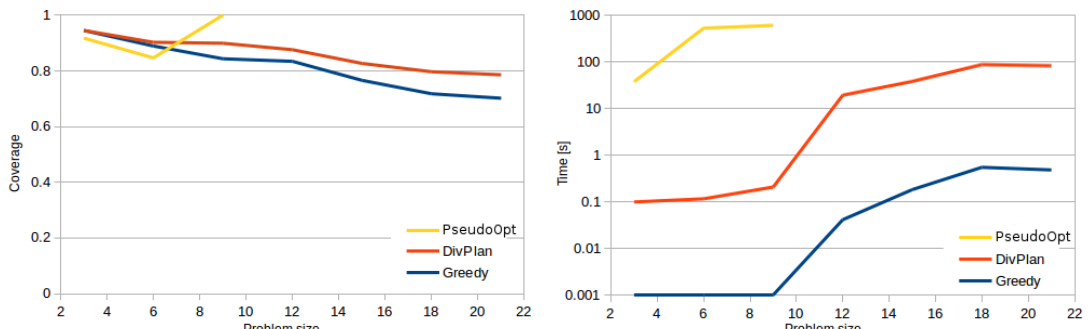
Figure 2. Time and coverage of solved sensor tasks comparison of all methods. Time of DivPlan is time needed to find final solution ( DivPlan was always granted 30 min timeout, but typically the final solution has been found within few seconds). Coverage of DivPlan and greedy is always counted for all the problems while for pseudo-optimal it is only over the solved problems. For size 9, the pseudo-optimal planner solved only approximately one fourth of the problem instances. These instances were solved by DivPlan and greedy algorithms with coverage 1 too.